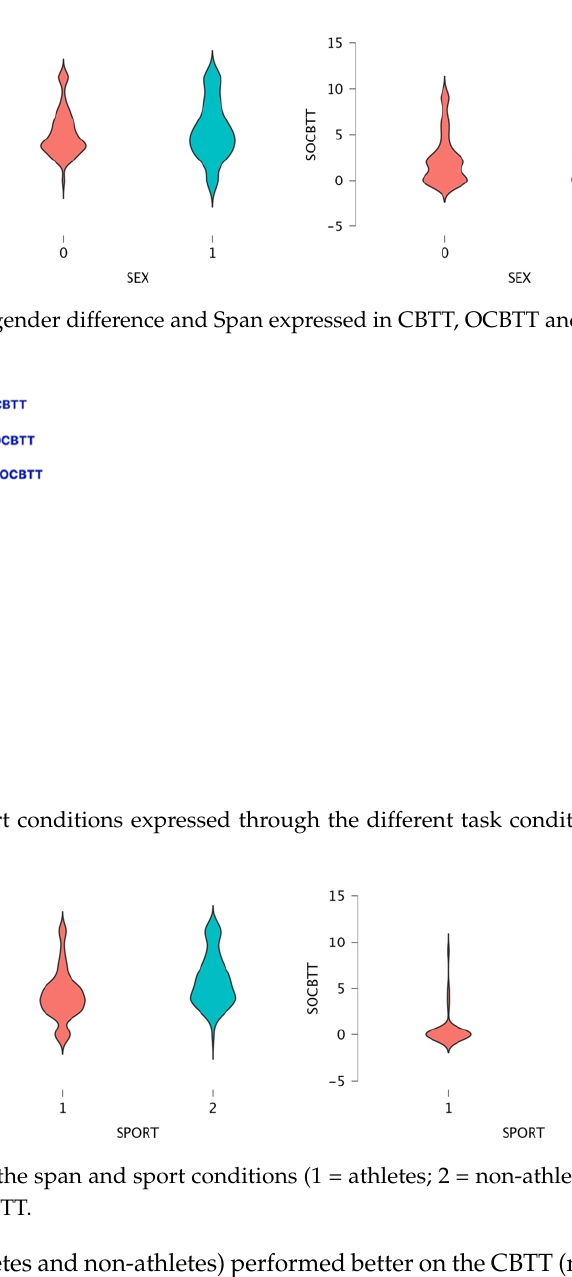
Figure 2. Gender difference and span expressed in the different task conditions (i.e., CBTT; OCBTT and SOCBTT).